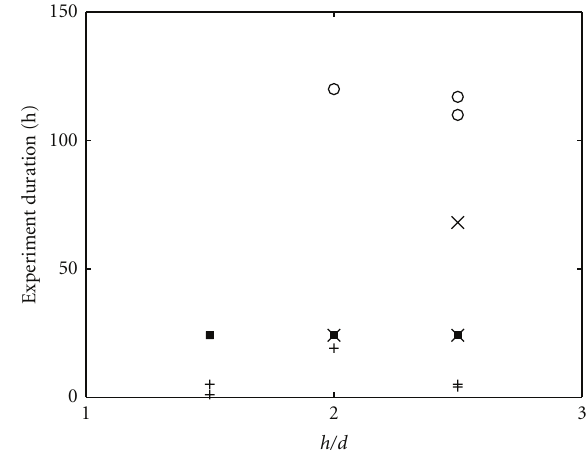
Figure 5: Canonical and live-bed results for Γ = 3. I = 1, w/d = 0 . 95 (line); I = 1 . 3, w/d = 0 . 95 (black circles); I = 1 . 3, w/d = 1 . 11 (squares); I = 1 . 3, w/d = 1 . 27 (triangles).